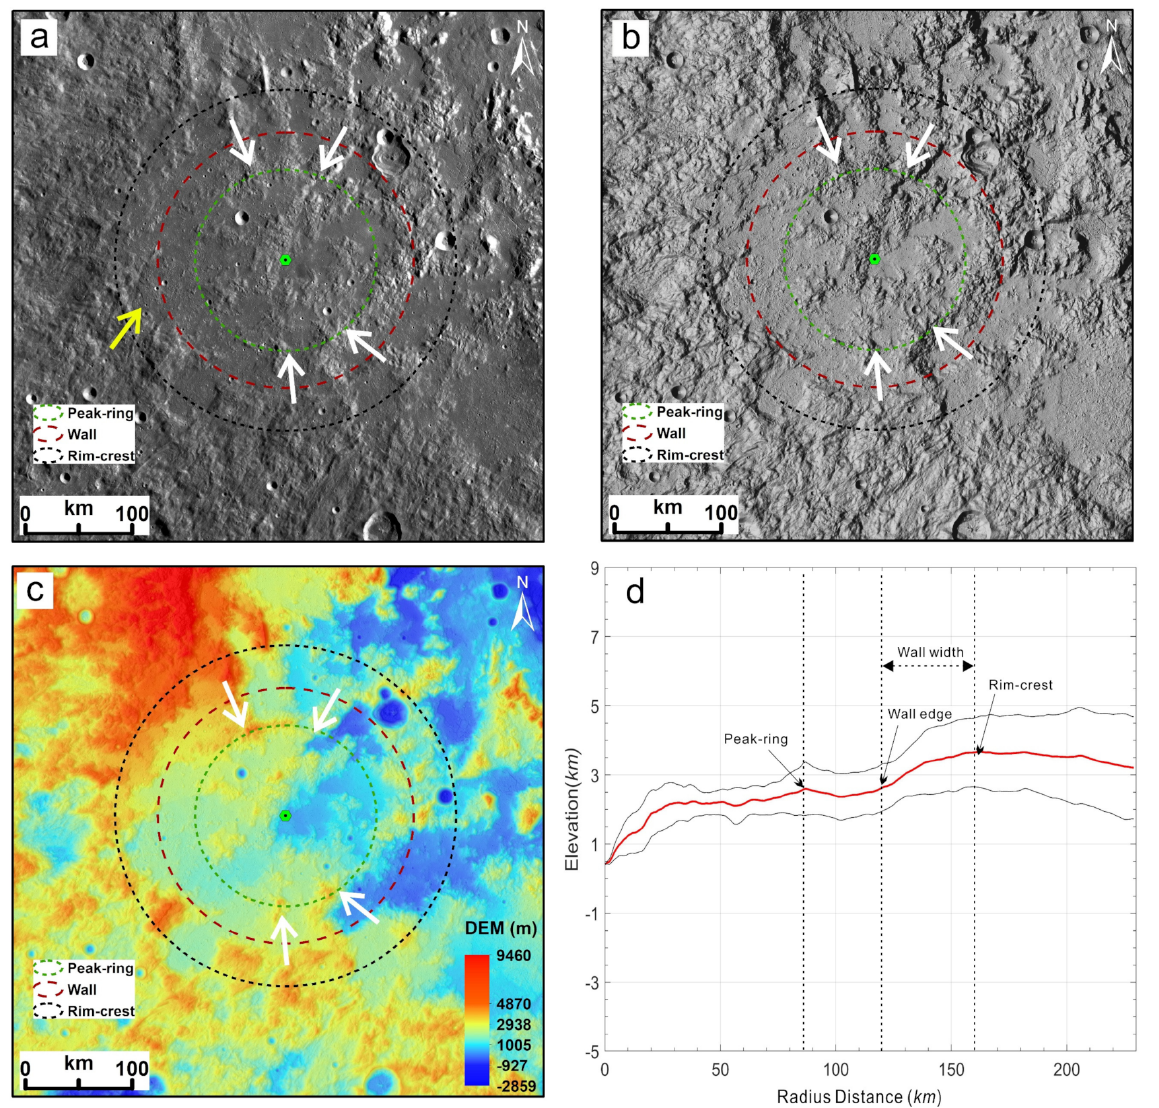
Figure 4. Southwestern region of the Orientale basin: ( a ) WAC image mosaic; ( b ) SLDEM2015 hillshade gridded topography; ( c ) SLDEM2015 colored gridded topography at 59 m/pixel; ( d ) average azimuth radial profile (red curve) of topography and uncertainties from the averaging are shown as one standard deviation (between the two black curves). The black circle is the rim–crest of the proposed peak–ring basin that is also found in the Bouguer anomaly map (Figure 2), the red circle is the proposed wall, which is the transition zone from the rim to the boundary of the basin floor, the green circle is the proposed peak ring, and the preserved peak–ring was marked by a white arrow and the lobe was marked by a yellow